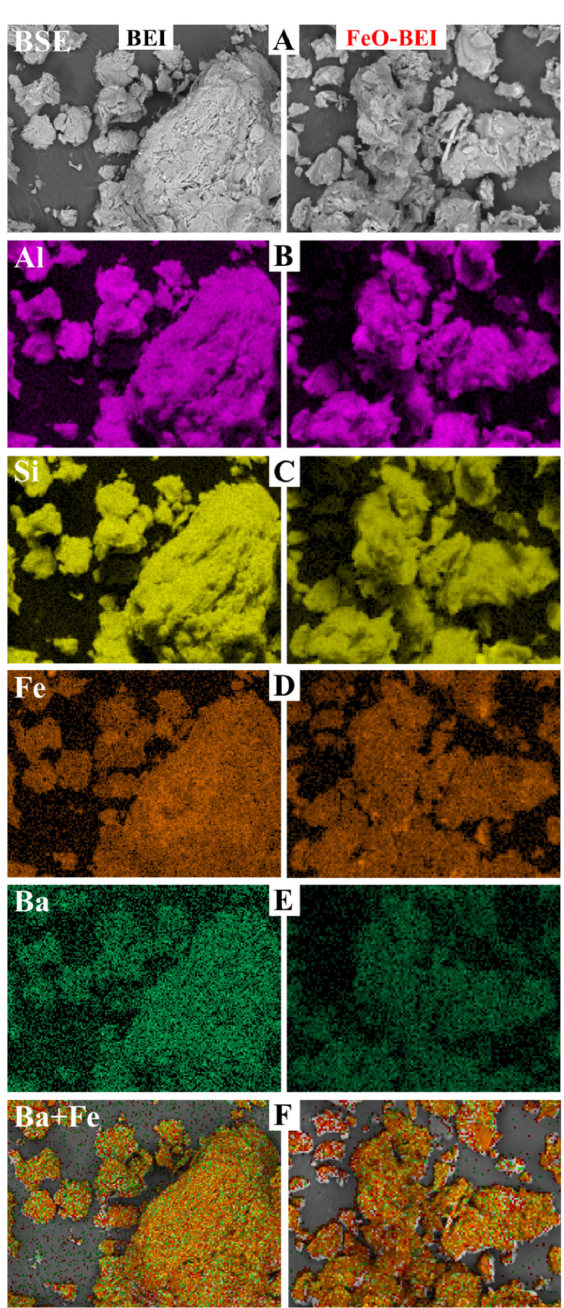
Figure 11. Backscattered electron images ( A ), distribution maps of Al ( B ), Si ( C ), Fe ( D ) and Ba ( E ) and overlay maps ( F ) of Ba (green) + Fe (orange) of BEI and FeO-BEI. Image width: all 15 µm.